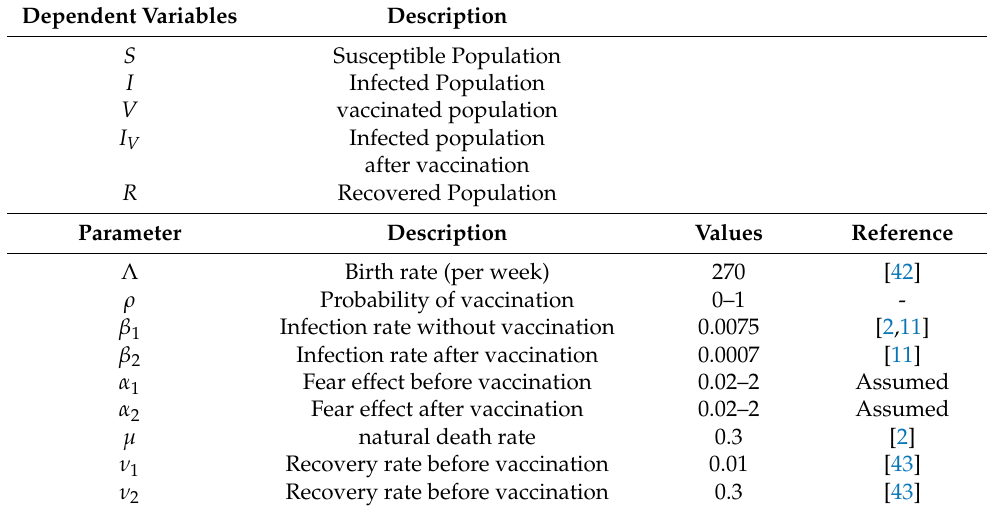
Table 1. Description and values of the parameters.